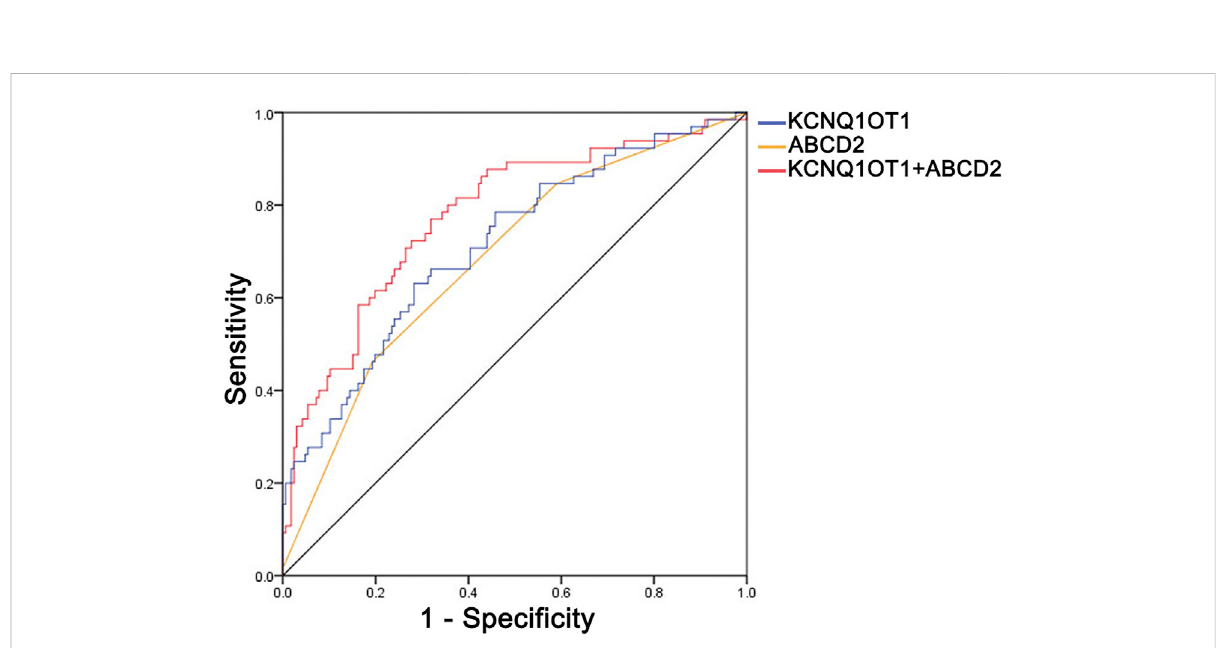
FIGURE 3 Receiver operating characteristic curve (ROC) of KCNQ1OT1, ABCD2-based risk level, and their combined application. The values of the area underthecurvewere0.714,0.672,and0.778,correspondingly,with63%sensitivityand72%speci fi cityofKCNQ1OT1and67.7%sensitivityand76.5% speci fi city of KCNQ1OT1 combined with the ABCD2-based risk